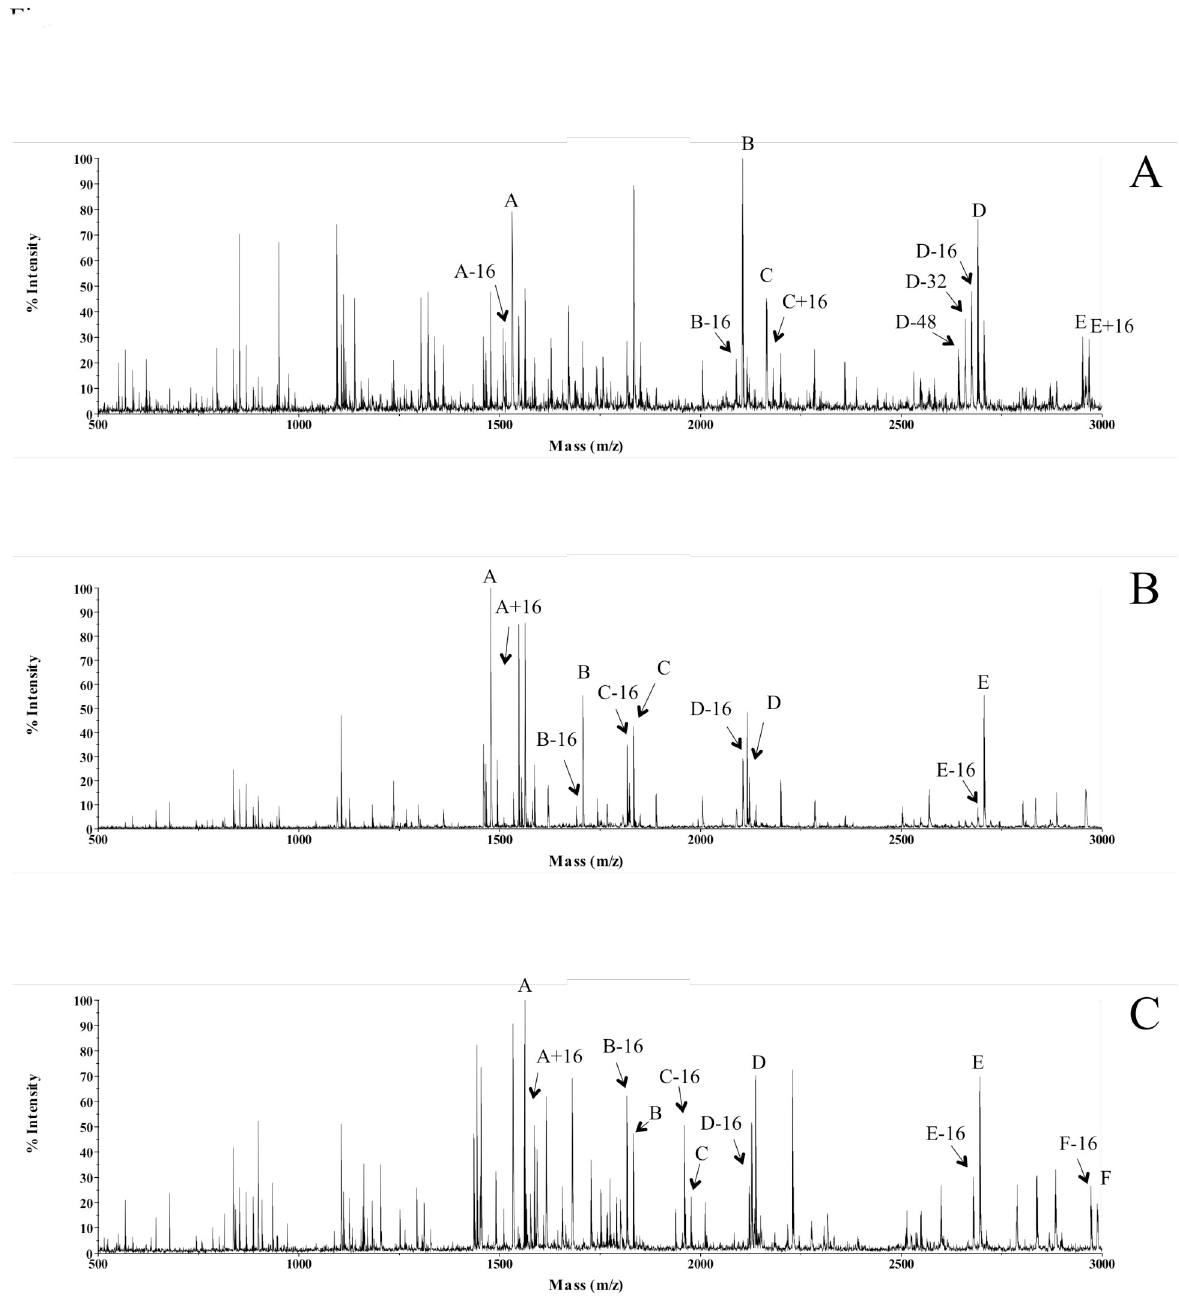
Fig 1. MALDI-TOF spectra of total trypsin digest. (A) Human collagen type III, (B) Human collagen type I, (C) Rat collagen type I. Peaks A–E in panel (A) and panel (B) and A-F in panel (C) are tryptic peptides of the corresponding collagens identified based on the agreement of their molecular weight (+1 ion) with that of the ‘theoretical value’ (assuming all Y-Pro as Hyp). The mass variants of 16 of each peak are labeled based on their mass differences from that of the ‘theoretical value’.